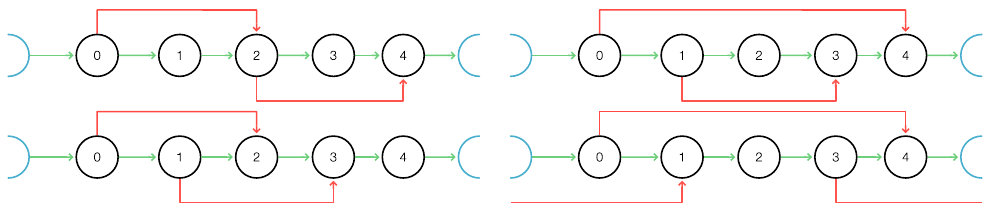
Figure 2. Relationships of distinct C -intervals. The four possibilities for the relative location of two distinct C -intervals are shown on a linear layout of a cycle C with five vertices (0,1,2, 3,4). Left top: the C -intervals C ( 0,2 ) and C ( 2,4 ) are disjoint . Right top: C ( 0,4 ) includes C ( 1,3 ) . Left bottom: C ( 1,3 ) extends C ( 0,2 ) , but not vice versa . Right bottom: C ( 0,4 ) and C ( 3,1 ) extend each other . Together, the two C -intervals cover C